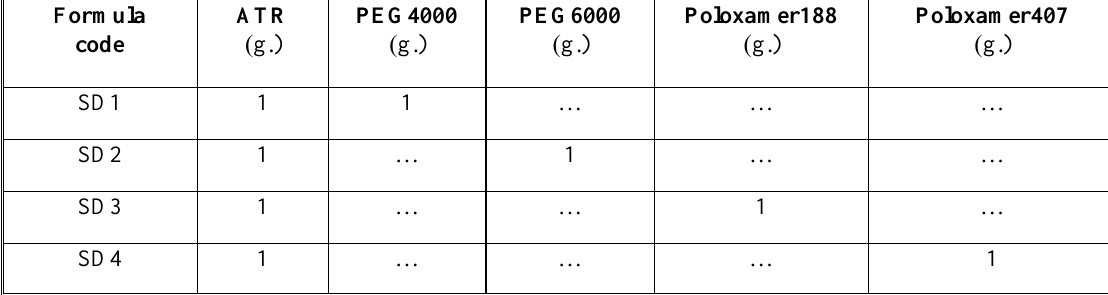
Table 1. Composition of different SD formulas of ATR